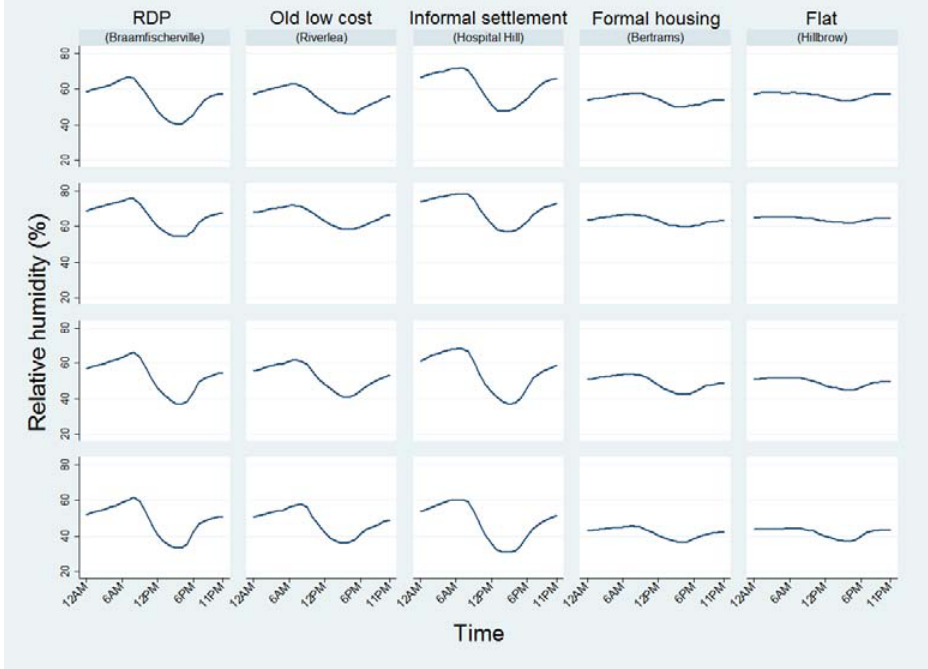
Figure 6. Mean relative humidity experienced throughout the day. Table 5. Coefficients (95% CIs) from the multilevel linear regression of temperature and apparent